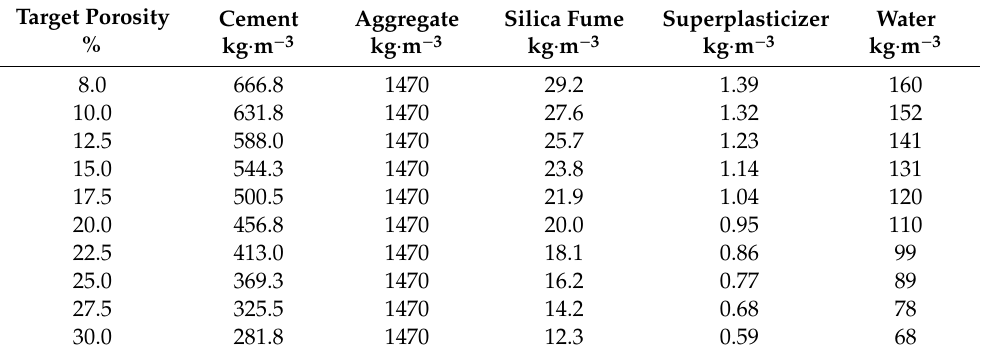
Table 3. Mix ratio design of pervious concrete under di ff erent target porosities.